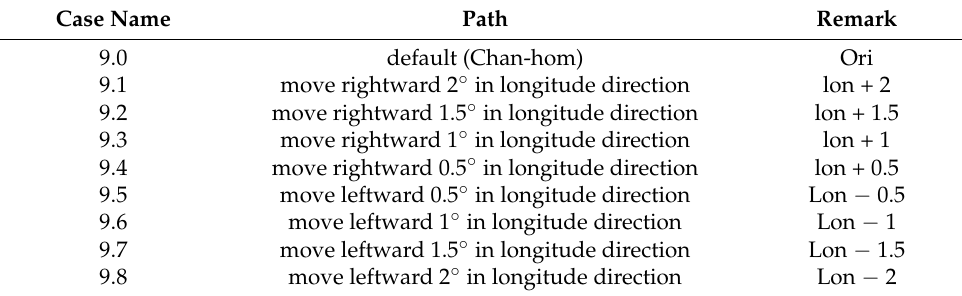
Figure 14. The path of Chan-hom (red solid line) and hypothetical paths (black solid lines). Table 6. Sensitivity experiments to explore the effect of typhoon path on storm surges.